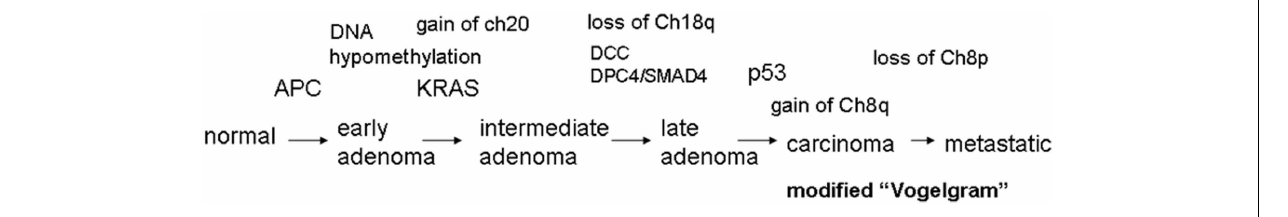
FIGURE 1 |The “Vogelgram” (modified from the original in Fearon andVogelstein, 1990) .The original “Vogelgram” (Fearon andVogelstein, 1990) mapped loss of chromosome 5q, 12p, 18q, and 17p, and mutations on APC, K-RAS, DCC, and p53 in a sequential order of cancer progression, although the importance of mutation accumulation, rather than sequential